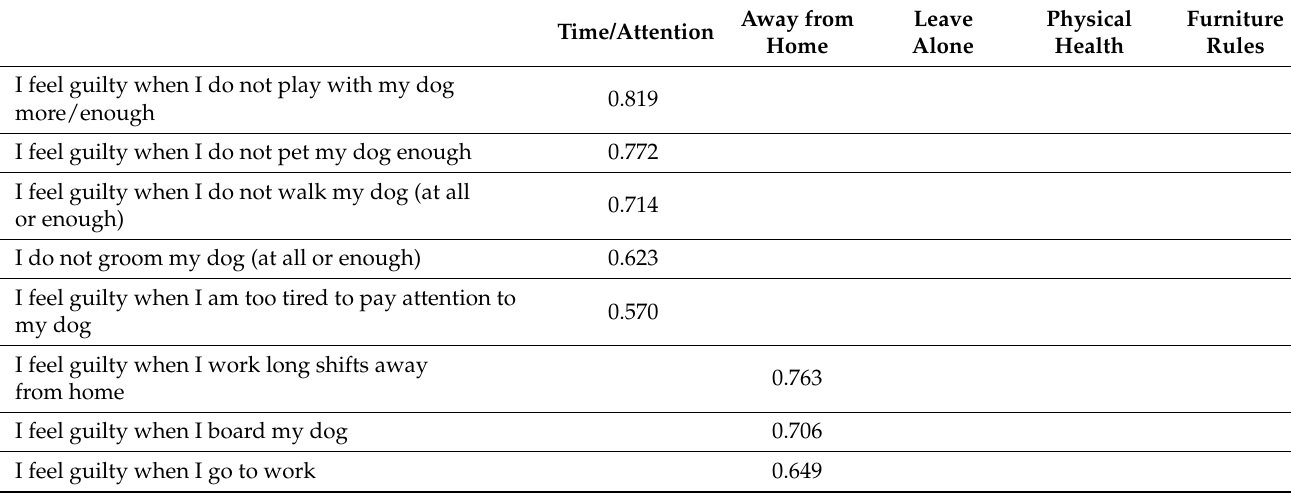
Table 2. Rotated component matrix for five dog-related guilt